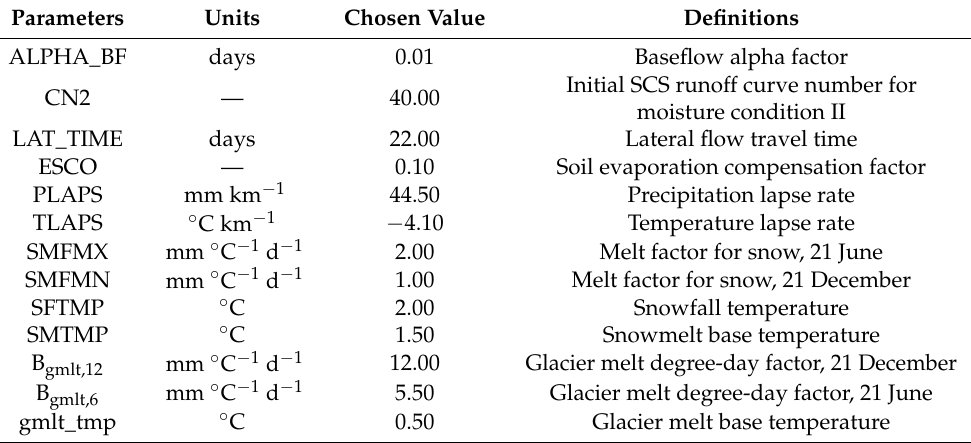
Table 2. The optimal parameter values for the Jinghe River Basin during Period 1.